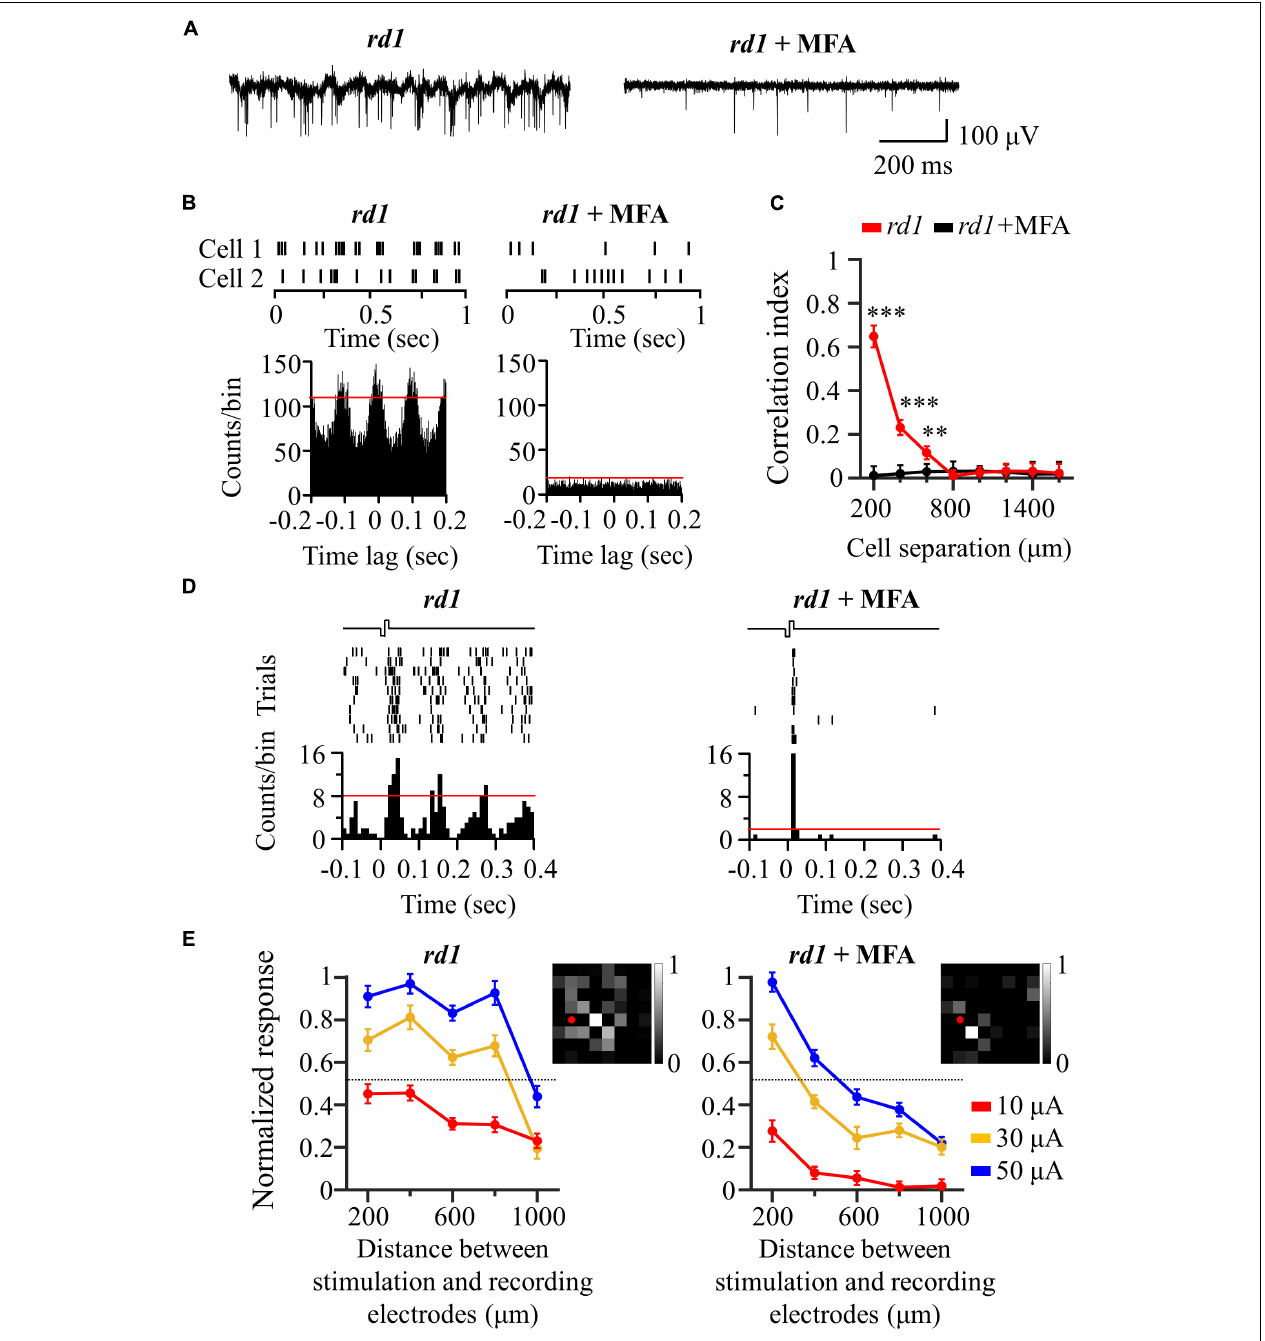
FIGURE 6 | Application of gap junction blocker (MFA) blocked inner-retinal neuron coupling. (A) Representative raw traces of RGCs were shown for 1 s in rd1 mice without and with gap junction channel blockers. (B) Changes in synchronized firing between rd1 RGCs after drug application. Top panels: raster plot of two RGCs with 200 µ m spacing on the MEA. Lower panels: cross-correlogram between RGCs. The time bin of correlograms is chosen to be 2 ms. The red line indicates the significance level represented by the 99% confidence limit of the correlogram. (C) CCI as a function of inter-RGC distance. Statistical differences before and after drug application are indicated by asterisks (*** p < 0.001, ** p < 0.01). (D) The responses of RGC that is 200 µ m away from the stimulation electrode to electrical stimulation with a pulse amplitude of 50 µ A and a pulse duration of 500 µ s. Top panels: raster plot of rd1 RGC (10 trials). Lower panel: PSTHs. The time bin for PSTH is chosen to be 10 ms. The red line indicates the significance level, expressed as the 99% confidence limit for PSTH. (E) Changes in normalized RGC response with the distance between stimulation and recording electrodes in the presence of gap junction channel blockers. Insets represent the spatial MEA colormaps (gray scale) for normalized RGC responses upon electrical stimulation with a pulse amplitude of 50 µ A and a pulse duration of 500 µ s in one representative retinal patch. Red dots indicate the position of stimulation electrodes.